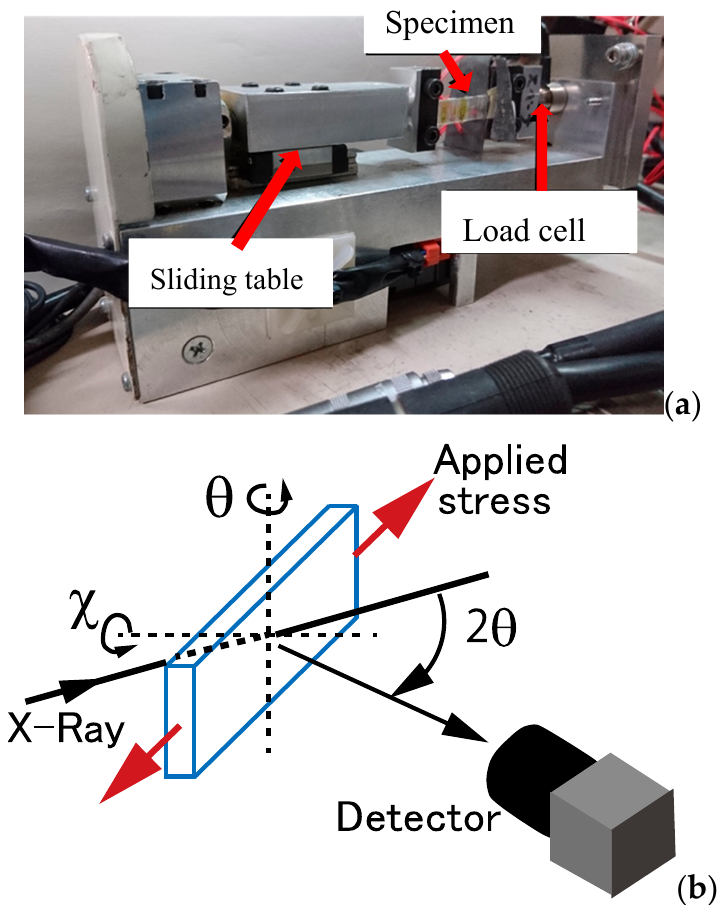
Figure 1. Tensile loading and X-ray measurement. ( a ) Loading device for in situ X-ray measurement; ( b ) Optical system for transmission geometry.